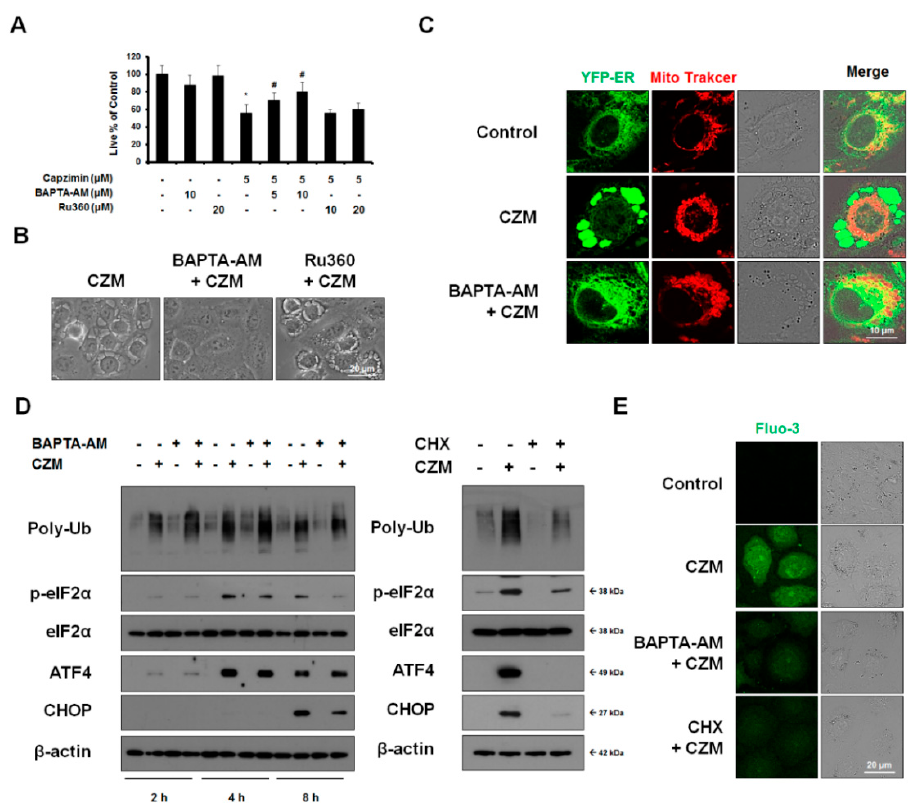
Figure 5. Disruption of both proteostasis and Ca 2+ homeostasis is required for the paraptosis induced by PSMD14 inhibition in MDA-MB 435S cells. ( A , B ) MDA-MB 435S cells pretreated with 10 µ M BAPTA-AM or 20 µ M Ru360 were further treated with 5 µ M CZM for 24 h or 12 h. ( A ) Cellular viability was assessed using IncuCyte, as described above * p < 0.001 vs. untreated cells, # p < 0.001 vs. CZM-treated cells. ( B ) Cells were observed by phase-contrast microscopy. Bars, 20 μ m. ( C ) YFP-ER cells were pretreated with 10 μ M BAPTA-AM or 20 μ M Ru360 were further treated with 5 μ M CZM for 8 h and stained with MitoTracker-Red. Cells were observed under the confocal microscope. Bars, 10 μ m. ( D , E ) Cells pretreated with 5 μ M BAPTA-AM or 1 μ M CHX were further treated with 5 μ M CZM for the indicated time durations or 8 h. ( D ) Western blotting of the indicated proteins was performed using β -actin as a loading control. ( E ) Cells were stained with Fluo-3 and observed by confocal microscopy. Bars, 20 μ m.